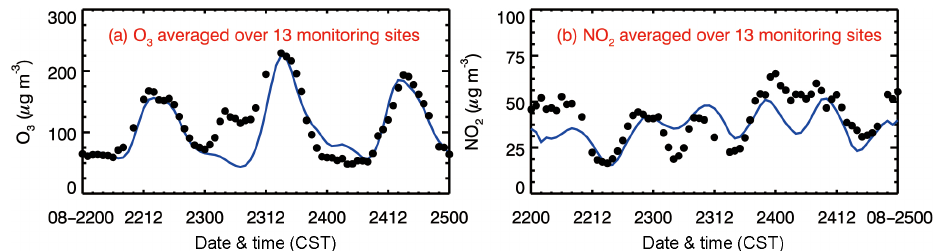
Figure 10. Comparison of measured (black dots) and simulated (blue line) diurnal profiles of near-surface hourly (a) O 3 and (b) NO 2 averaged over all ambient monitoring stations from 22 to 24 August